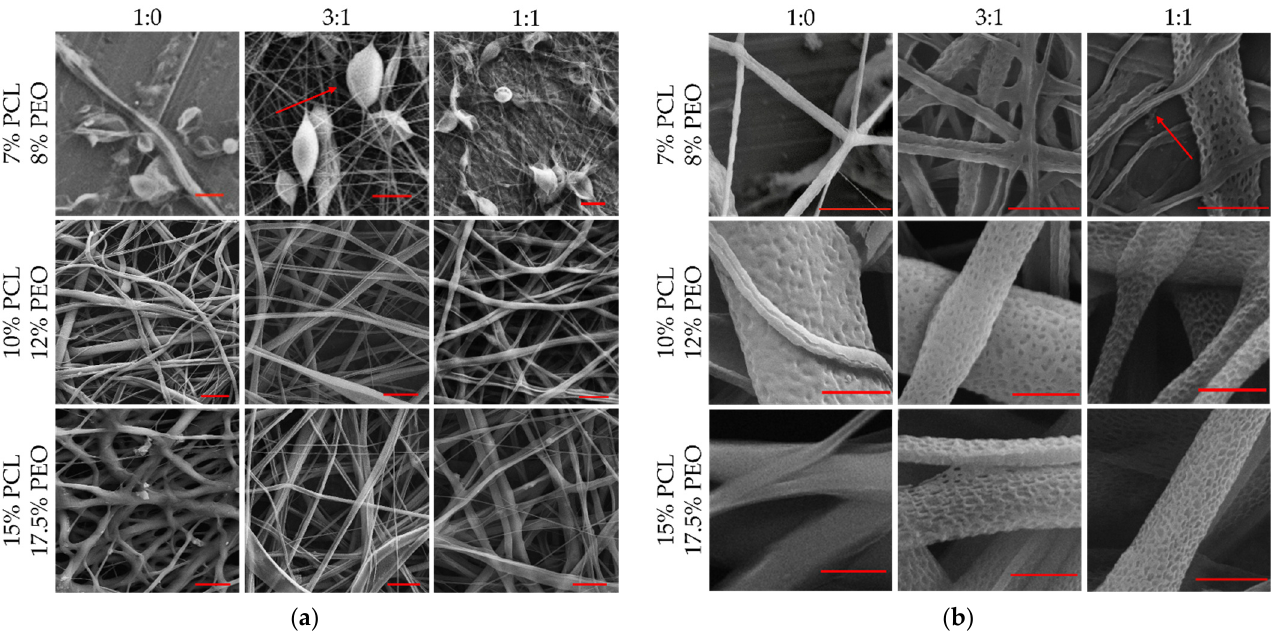
Figure 4. SEM images for PCL nanopores microtubes. ( a ) microtubes under 10 µm scale bar; ( b ) nanopores under 2 µm scale bar.